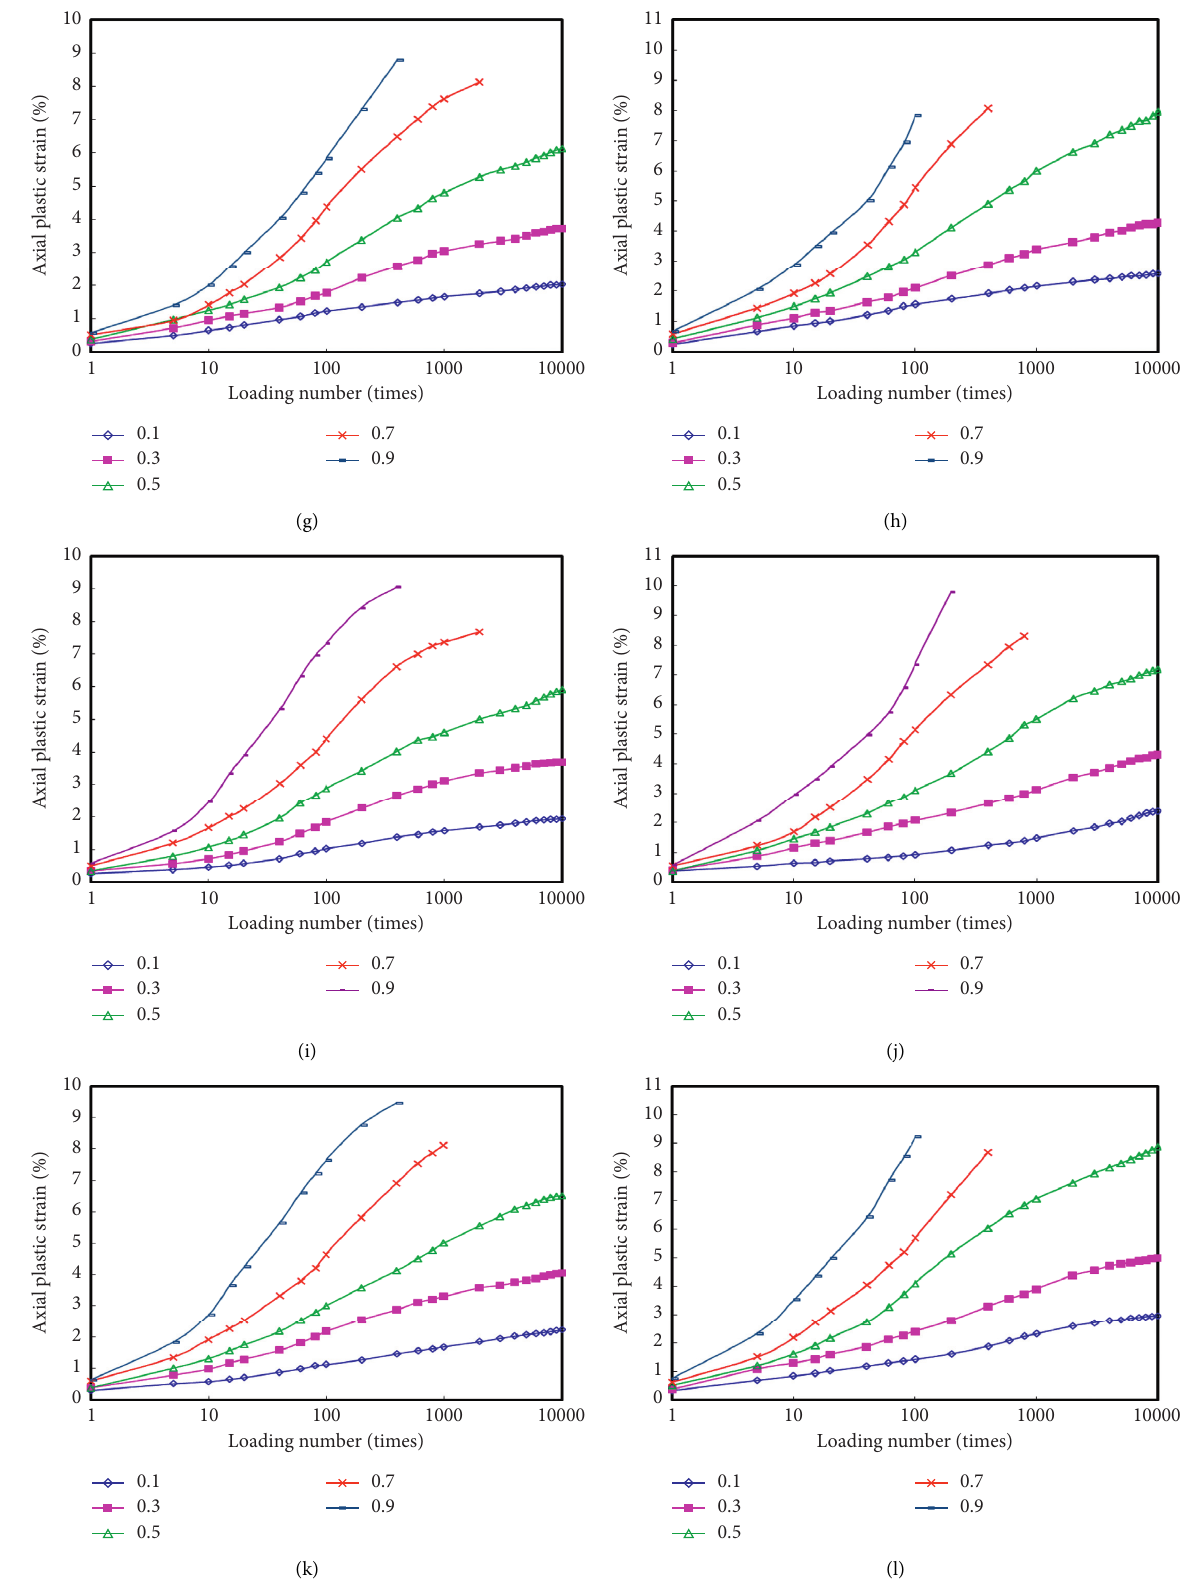
Figure 4: Relations between the axial strain and loading number under different stress levels. (a) σ σ 3 � 50kPa, LX1, (d) σ 3 � 50 kPa, LX2, (e) σ 3 � 100kPa, GM, (f) σ 3 � 100kPa, GF, (g) σ 3 � 100kPa, LX1, (h) σ 3 � 100kPa, LX2, (i) σ 3 � 150kPa, GM, (j) σ 3 � 150kPa, GF, (k) σ 3 � 150kPa, LX1, and (l) σ 3 � 150 kPa,